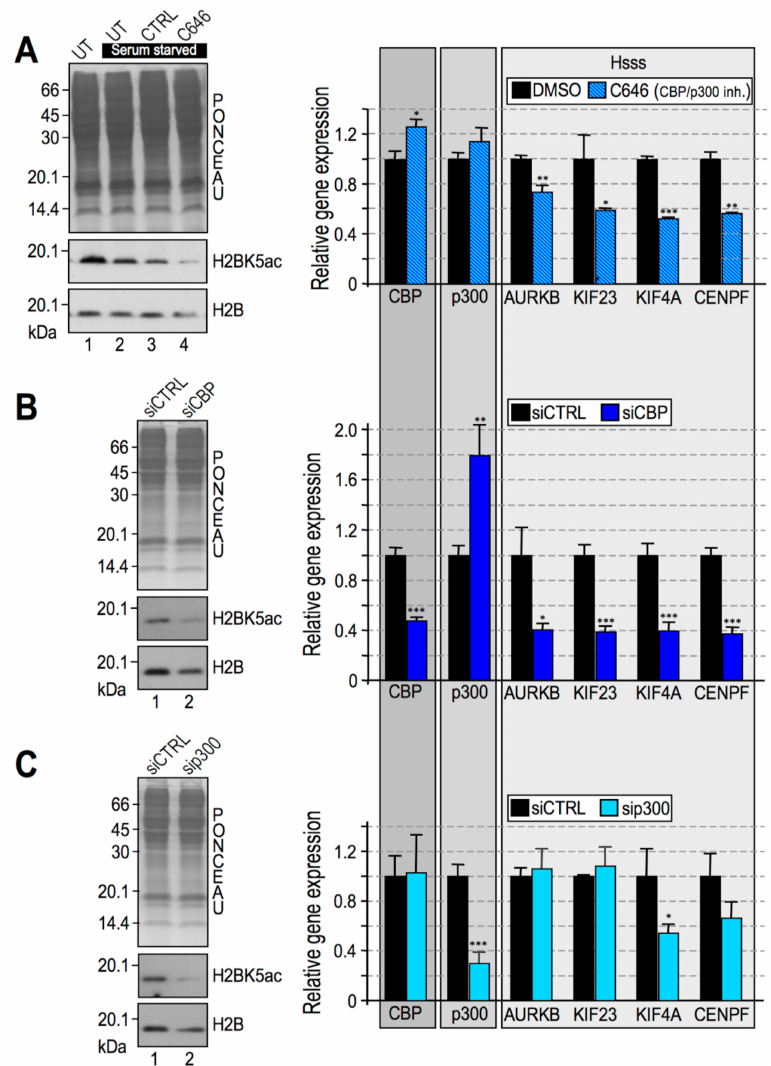
Figure 6. CREB-binding protein (CBP) is linked to the gene expression regulatory role of High Mobility Group A1. ( A , B , and C —left side) Western blot (WB) analyses performed with MDA-MB–231 cell lysates. Cells were grown with complete medium (lane 1) or serum-starved medium (lanes 2, 3 and 4) for 24 h before treatment with 20 µ M C646 or 0.2% dimethyl sulfoxide (DMSO) as a control (CTRL). UT (untreated) represents cells treated neither with C646 nor with DMSO ( A —left side). MDA-MB–231 cell lysates silenced for CBP and p300 (siCBP and sip300) and their relative controls (siCTRL) ( B and C —left side, respectively). All WB experiments were performed in biological triplicate, providing consistent results. Representative images are shown. ( A , B , and C , right side) qRT-PCR analyses of serum-starved MDA-MB-231 cells treated for 24 h with 20 µ M C646 ( A , right side) MDA-MB-231 cells silenced for CBP ( B , right side) or p300 ( C , right side) and their respective controls (DMSO and siCTRL). The four HMGA–signature genes (Hsss) were analysed together with CBP and p300. Glyceraldehydes-3-phosphate dehydrogenase (GAPDH) or cyclophilin-33 (CYP33) were used as internal reference genes. Mean, standard deviations ( n = 3), and statistical significance ( t -test) are indicated (*: p < 0.05; **: p < 0.01; ***: p <